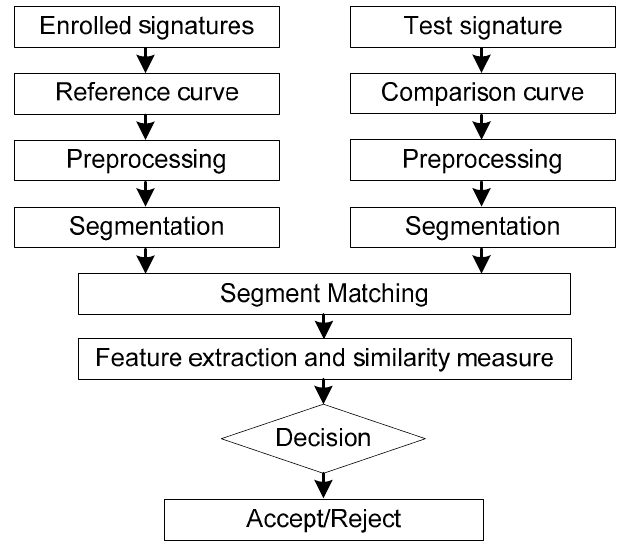
Figure 4. Block diagram of the proposed system.